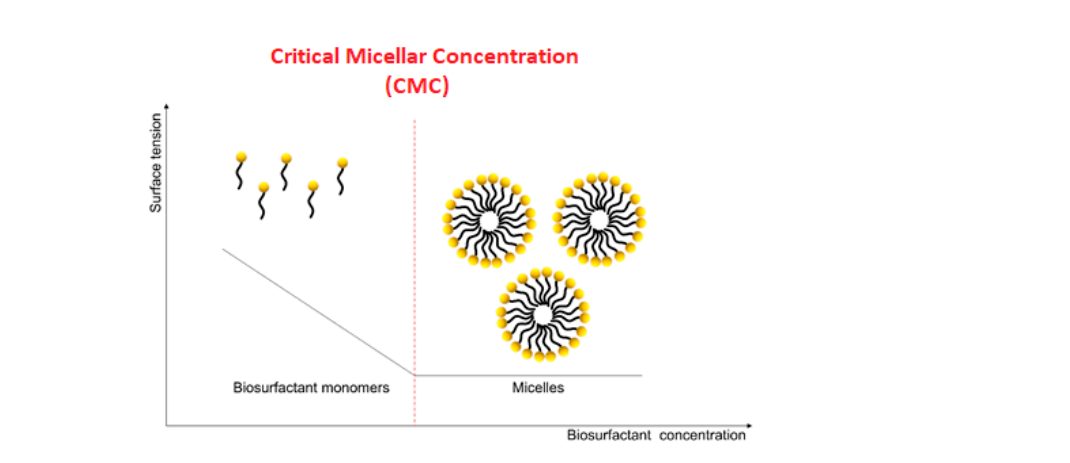
Figure 1. Representation of biosurfactant action. Micelle formation after reaching critical micellar concentration.